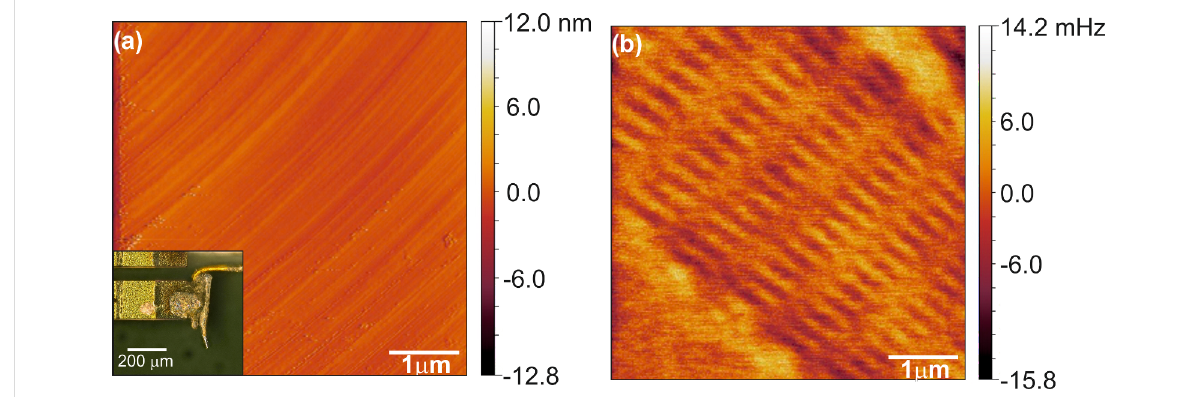
Figure 2: Lift Mode FM-MFM image using a qPlus sensor with an etched iron tip attached to it (see inset in a). Flattened raw data with imaging para- meters f